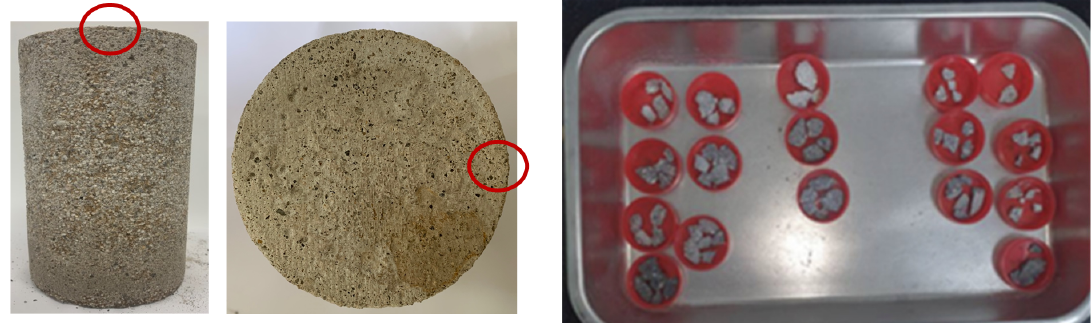
Figure 5. Surface location of collected sample immersed for 28 days and collected samples.